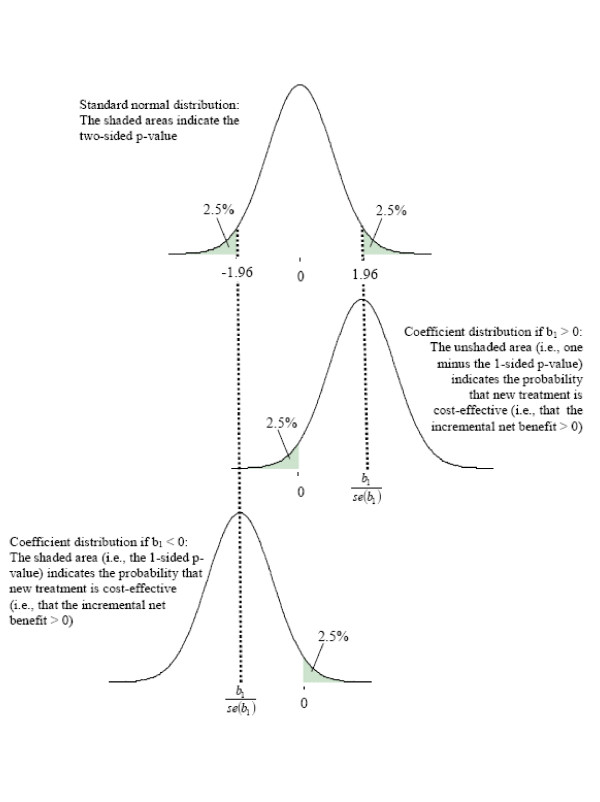
Illustrating the relationship between the p-value for the "new treatment" indicator variable in a net benefit regression (i.e., b1the incremental net benefit) and the probability that a new treatment is cost-effective